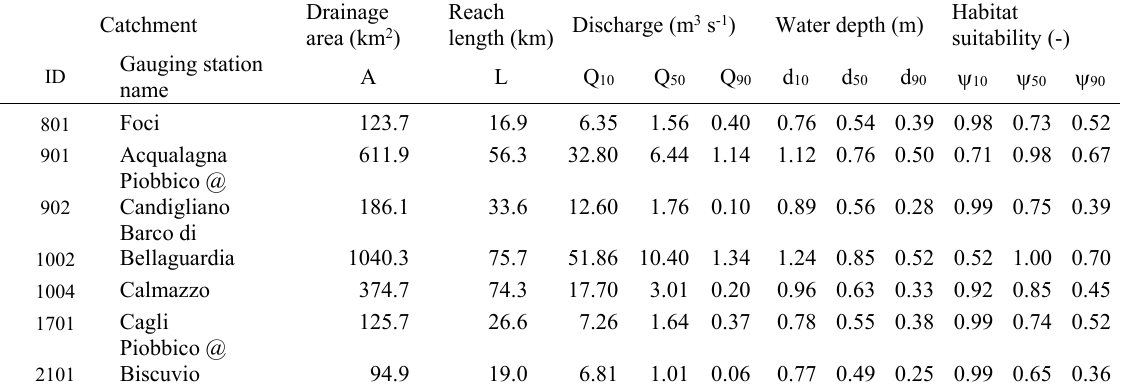
Table 1 Summary of the key geomorphologic, hydrologic and stream ecological features for the seven sub- basins of the Metauro River.